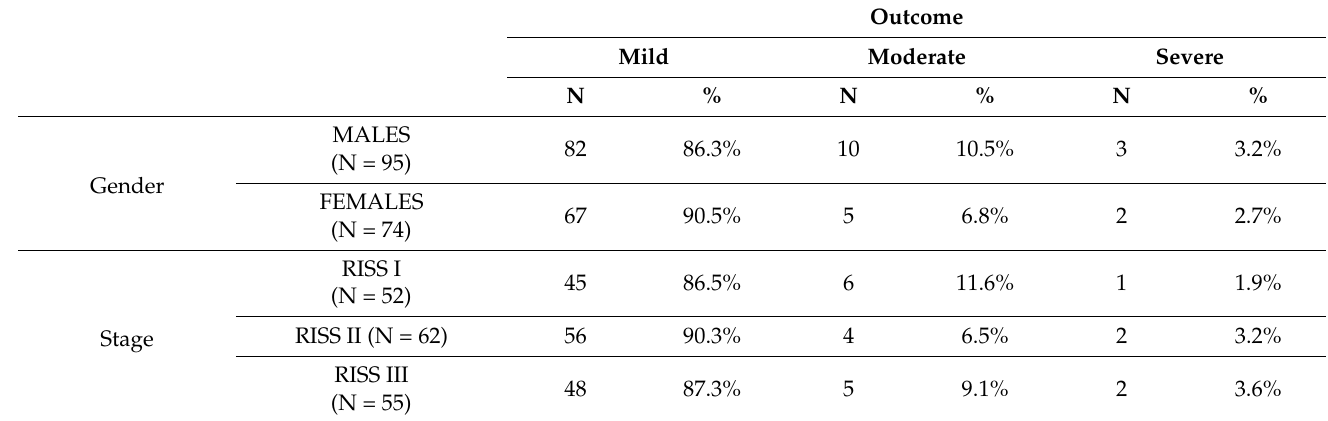
Table 5. Distribution of gender and MM stage according to the outcome of COVID-19 infection.